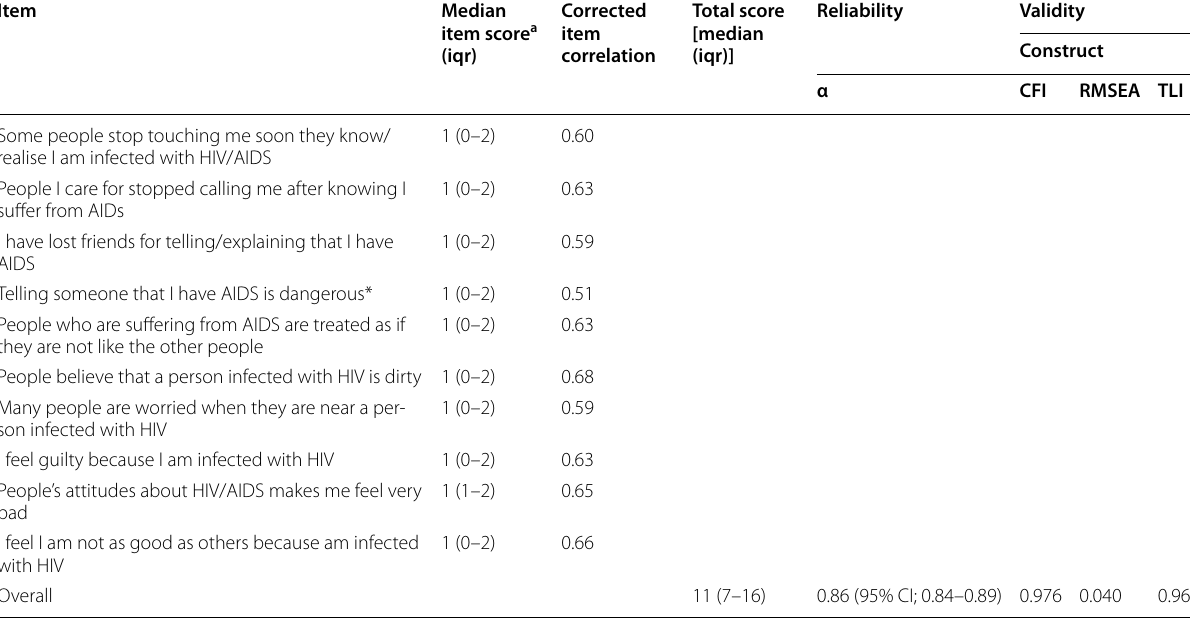
IQR interquartile Range a Possible score for each item 1–4; higher scores reflect a higher level of perceived HIV stigma